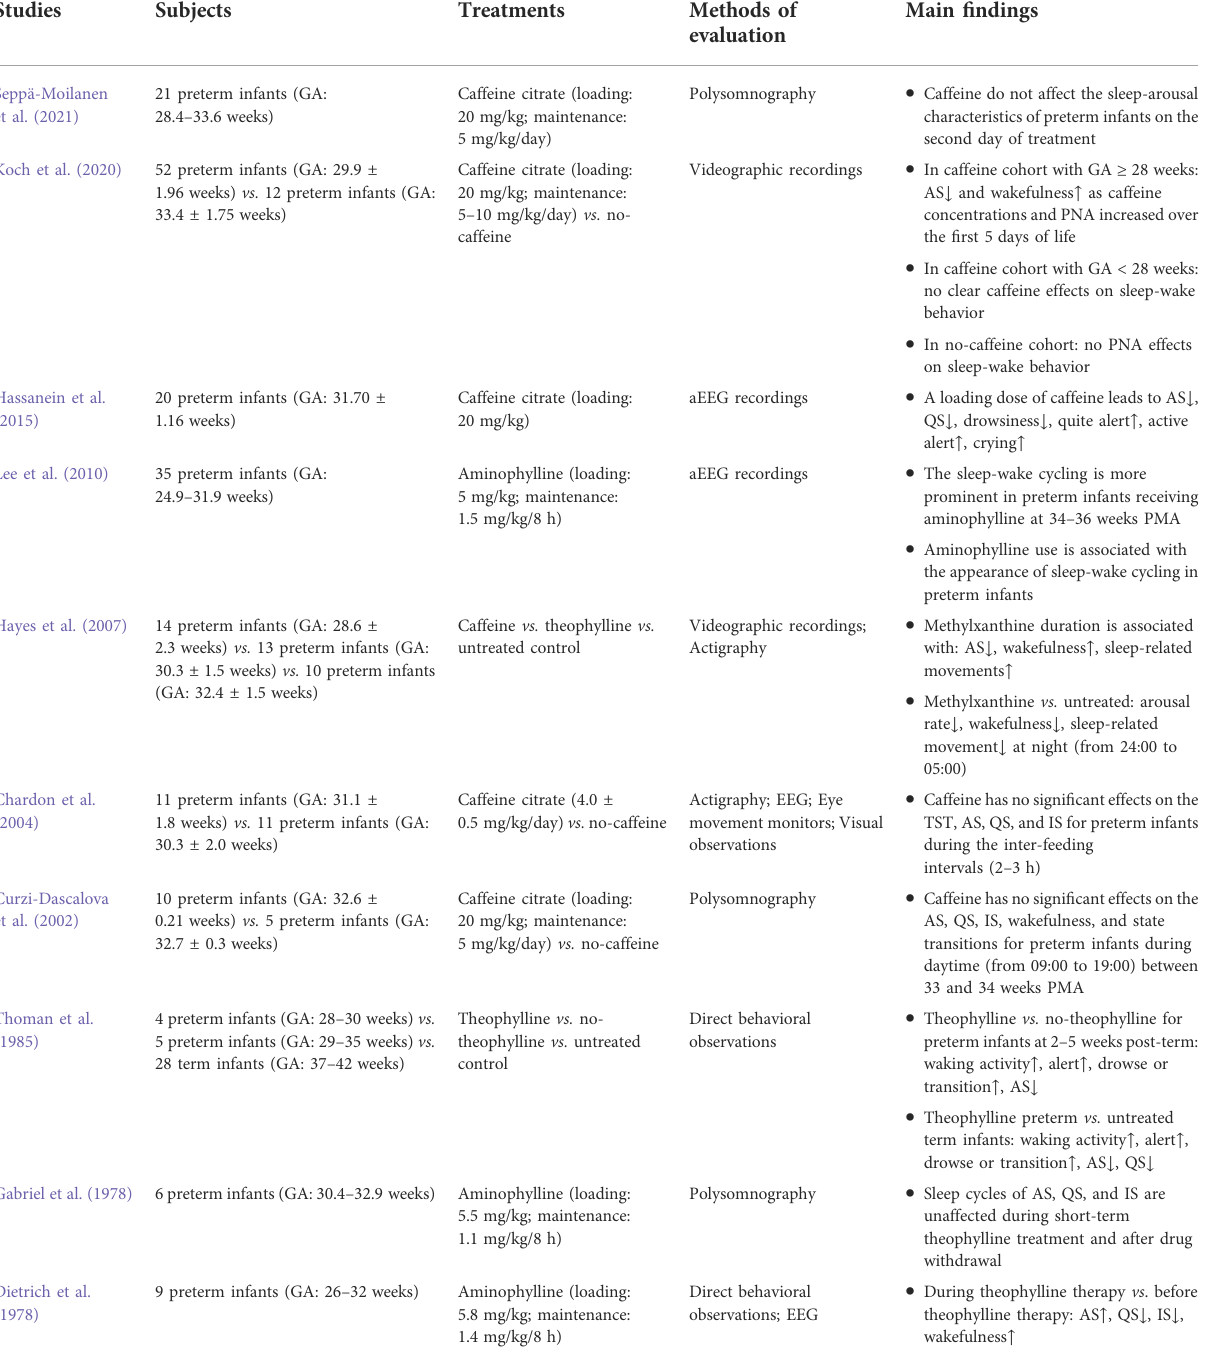
TABLE 5 Studies about the effects of methylxanthine on sleep-wake rhythms in preterm infants.